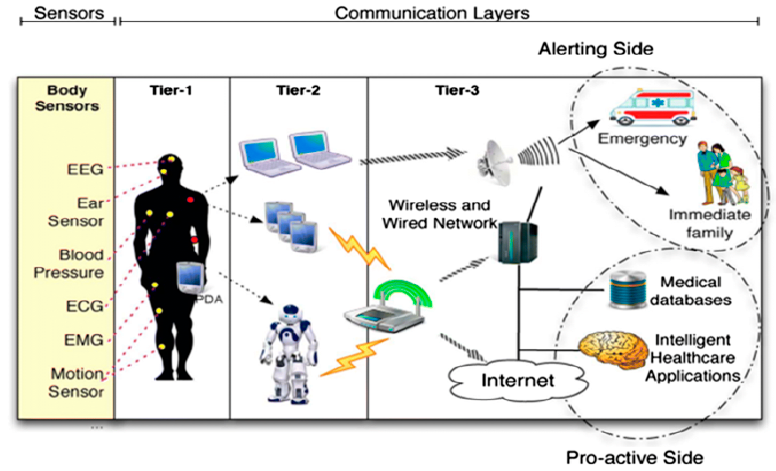
Figure 6. Sensors using the IoT in healthcare systems.